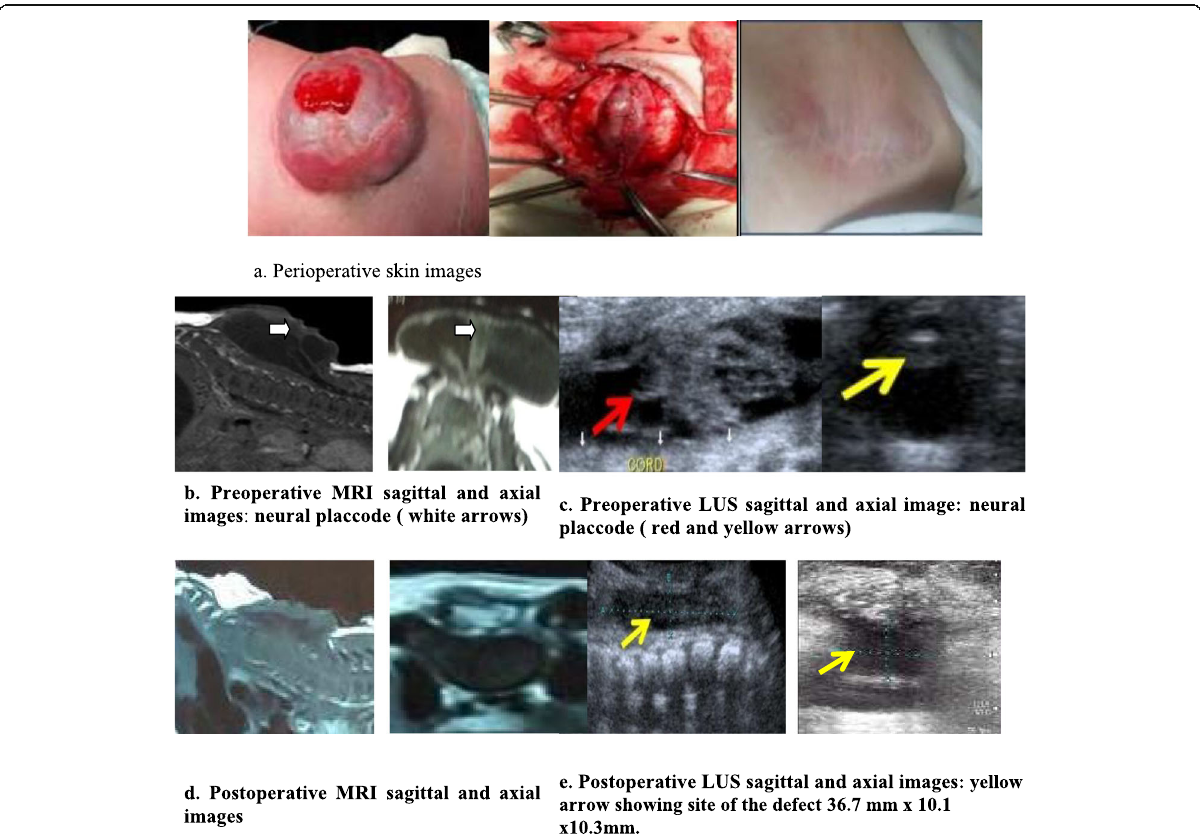
Fig. 3 Meningomyelocele. a Perioperative skin images. b Preoperative MRI sagittal and axial images: neural placode (white arrows). c Preoperative LUS sagittal and axial image: neural placode ( red and yellow arrows). d Postoperative MRI sagittal and axial images. e Postoperative LUS sagittal and axial images: yellow arrow showing site of the defect 36.7 mm × 10.1 × 10.3